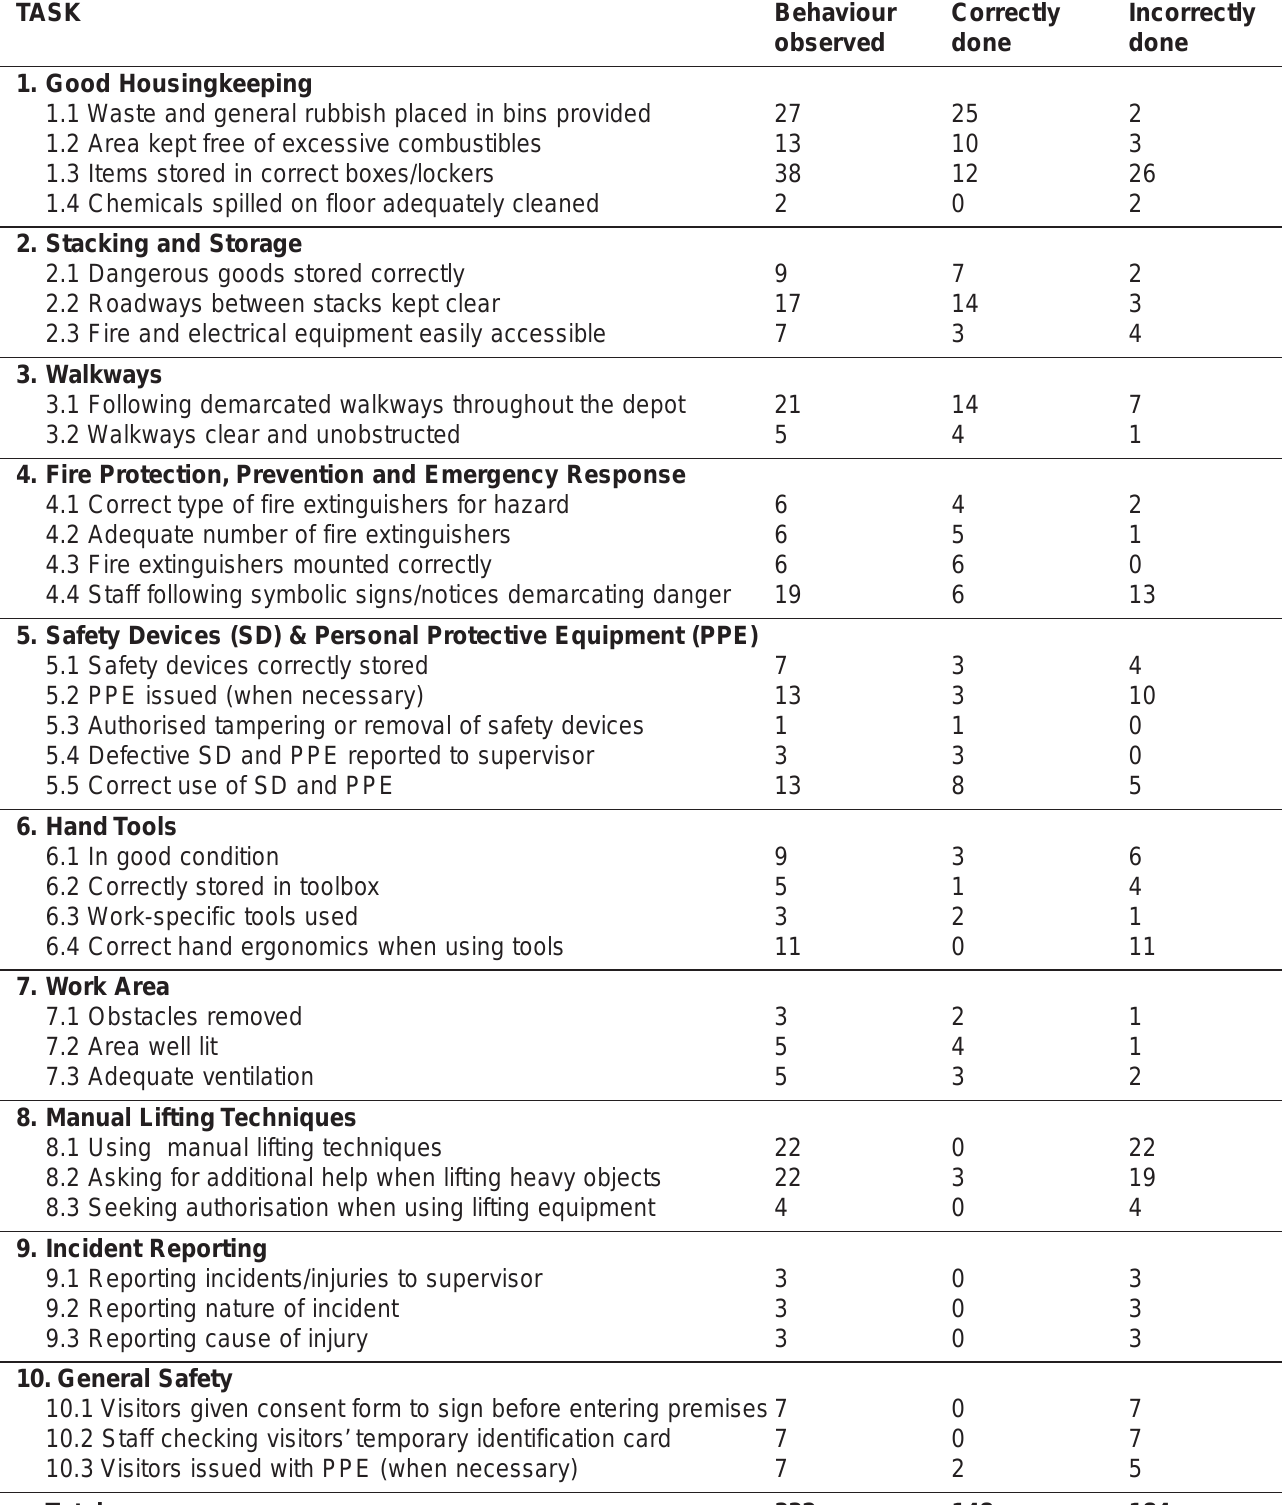
Table 1: Checklist depicting the number of health and safety violations observed